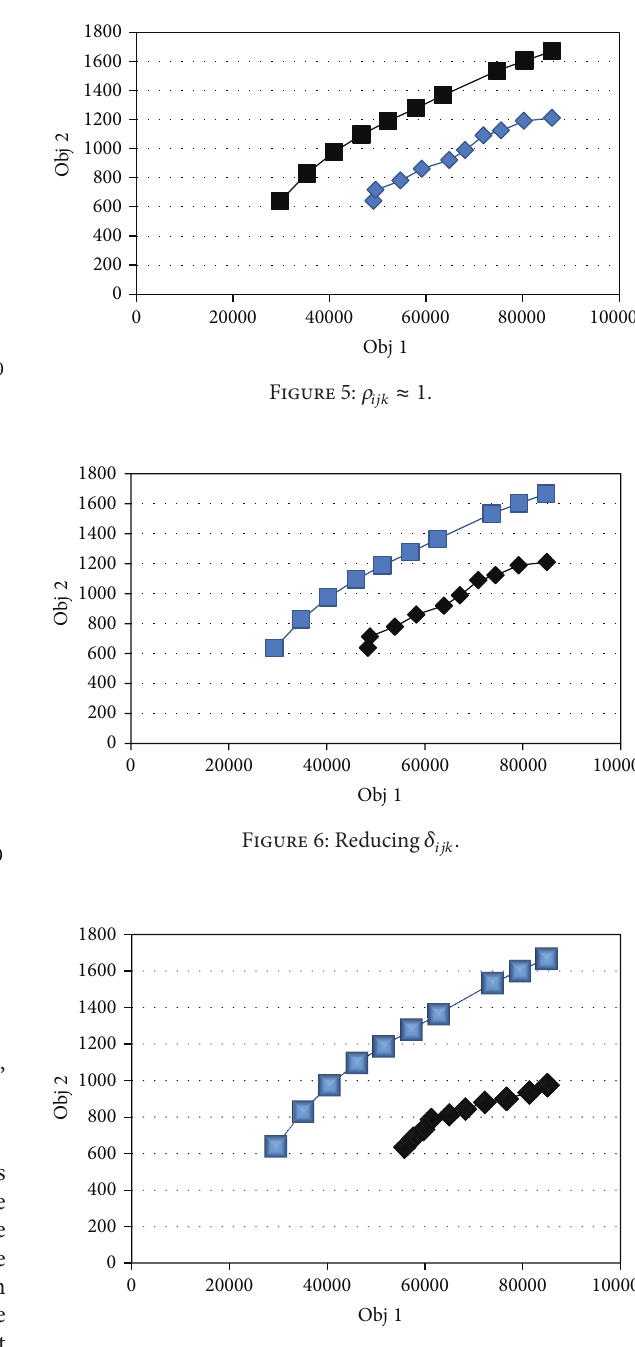
Figure 7: Reducing 𝑁 𝑖𝑗𝑘𝑘 󸀠